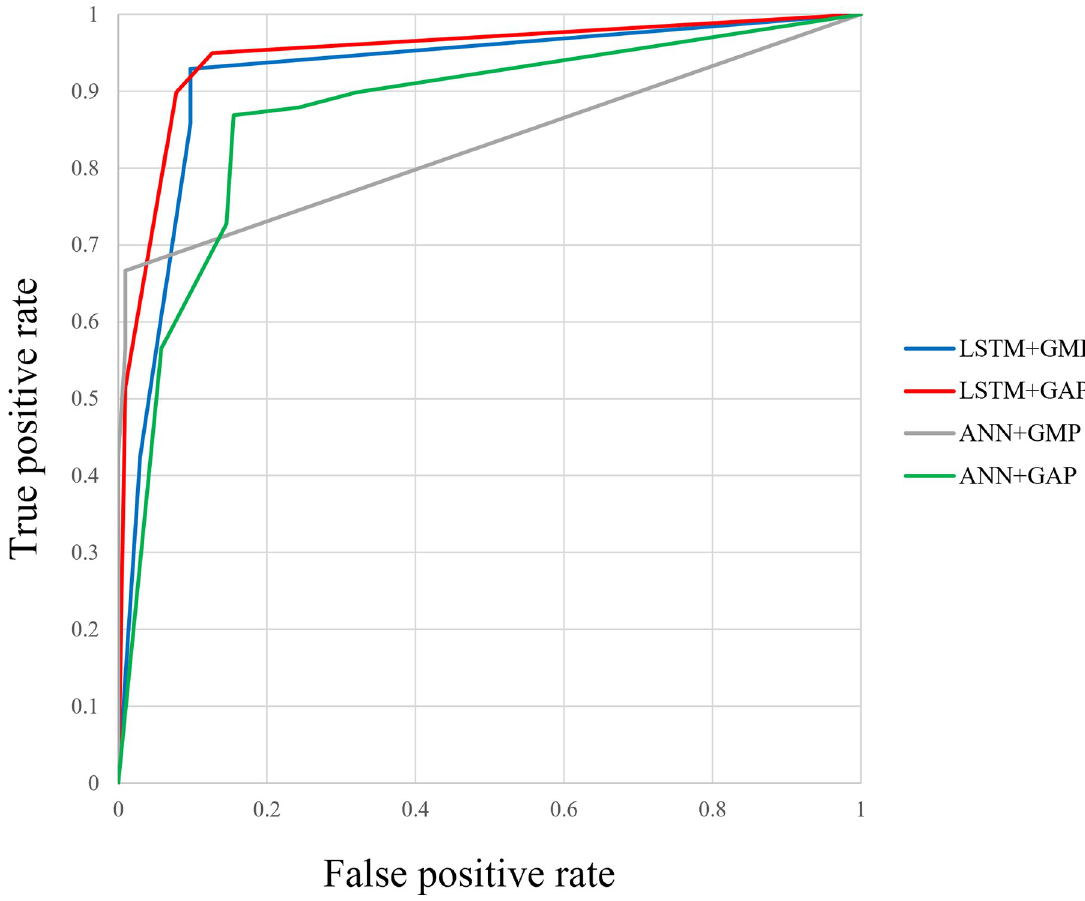
Fig 13. ROC curves of the GAP versus GMP in long-axis